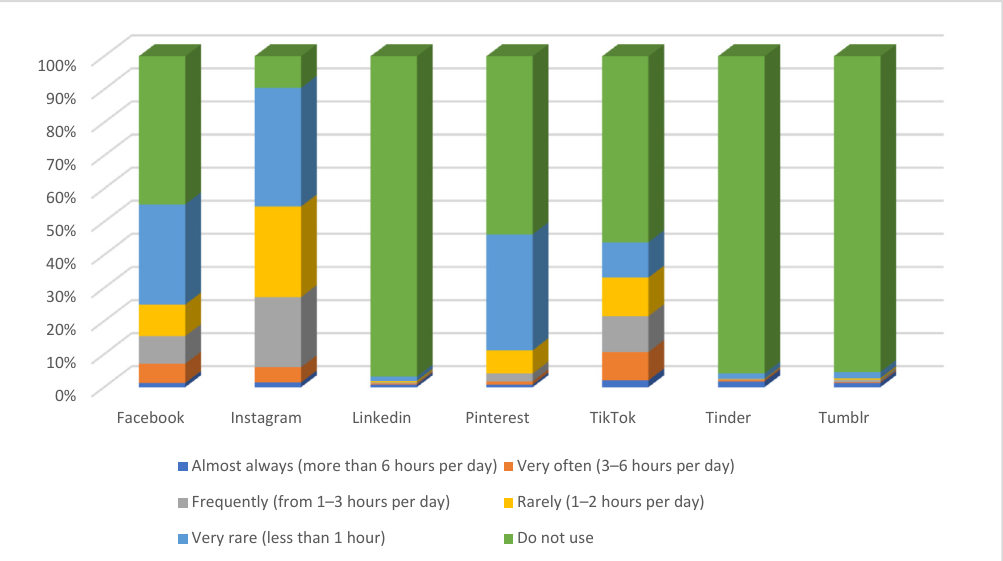
Figure 3. Exposure to social networks.